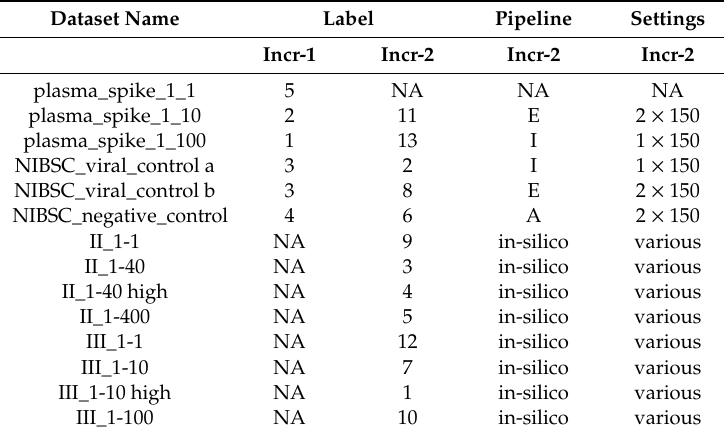
Table 1. Sample labels in increments 1 and